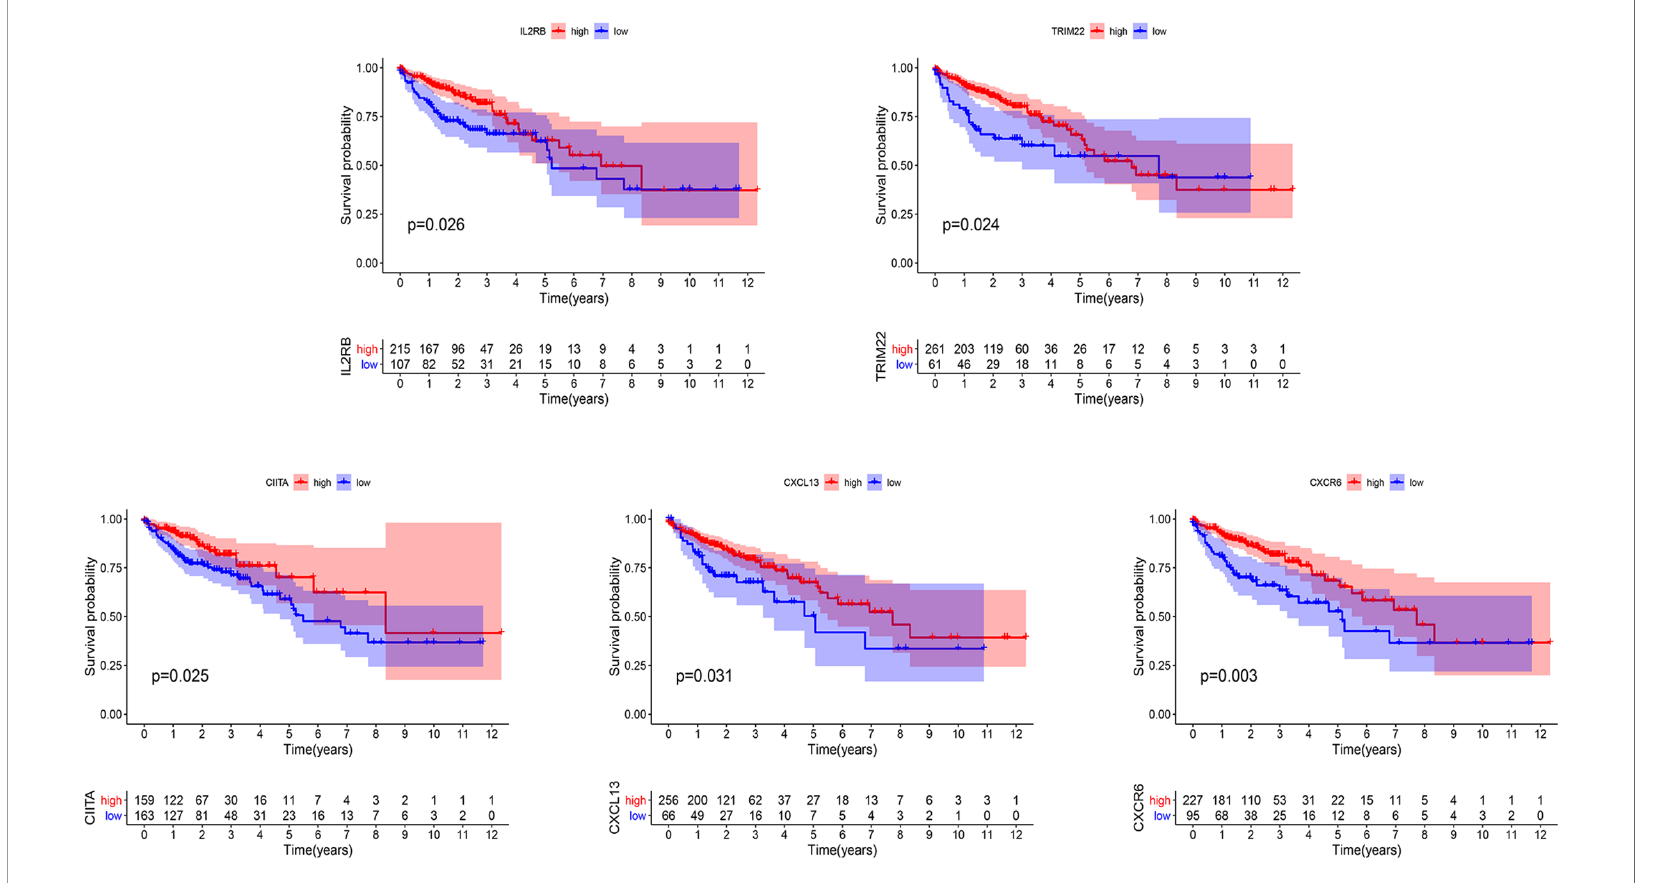
FIGURE 7 | Kaplan-Meier curves of overall survival in fi ve prognostic key IRGs. IRGs, immune related